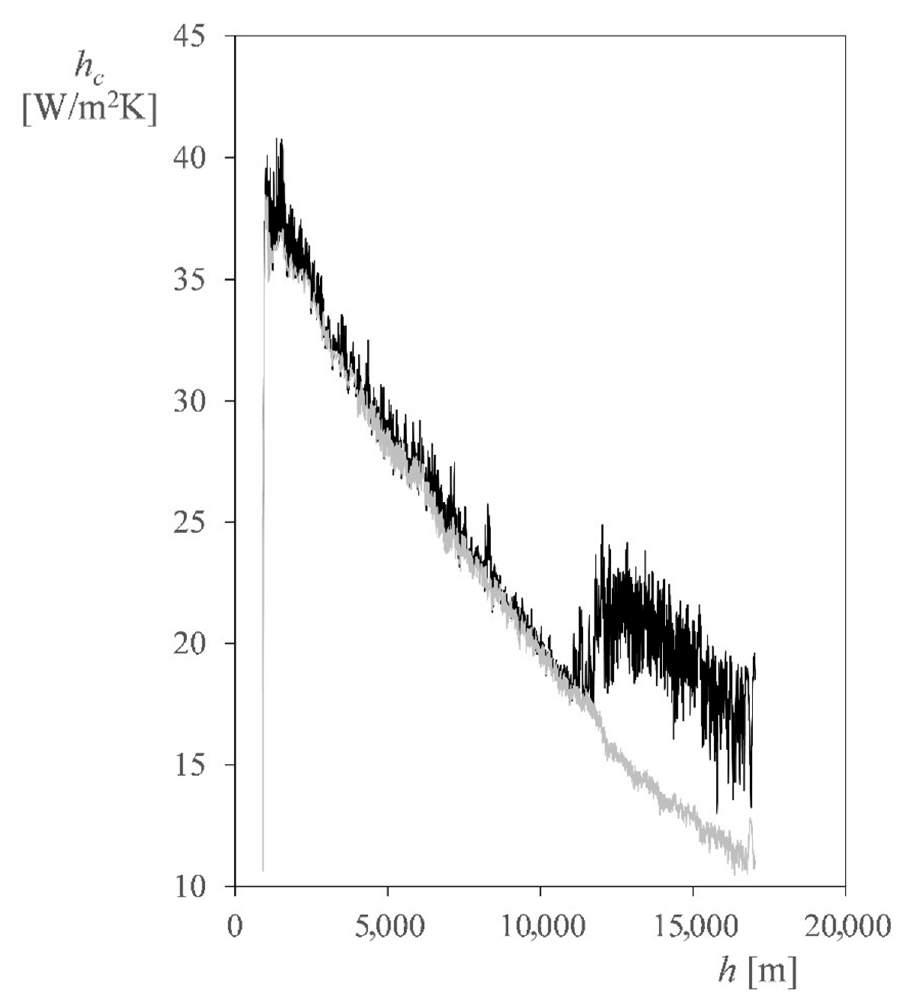
Figure 10. Convection coefficient, h c , of a vertical aluminum square plate that is 0.1 m side-long and 0.005 m thick vs. altitude. This coefficient was calculated with the wind speed measurements. The black line represents the case considering both vertical and horizontal wind speeds, V z and V , and the grey line represents the case considering only vertical wind speed (see Figure 8).